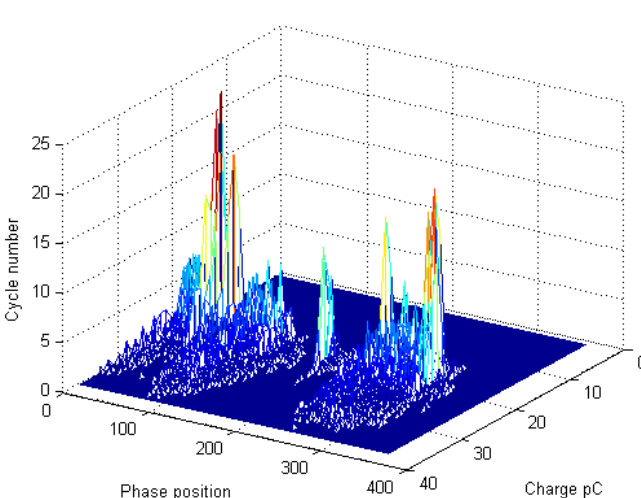
Figure 16. Failure in T-phase cable termination.